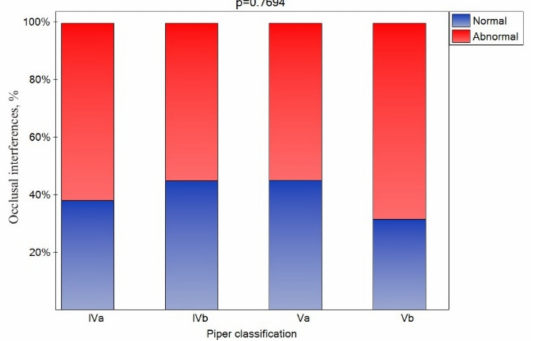
Figure 6. Impact of the Piper classification on the occlusion interference (statistically significant effect was assumed for p <